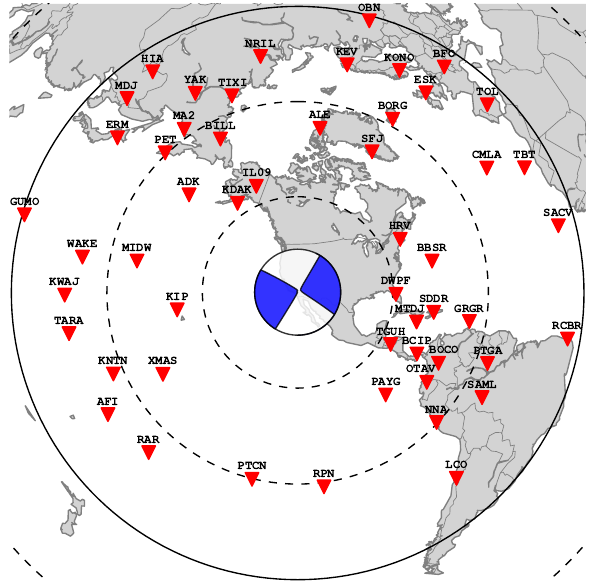
Figure 20. Stations used in the source inversion validation (SIV) exercise. Circles mark 30, 60 and 90 ◦ epicentral distance. The fi- nite source is a M 7.8 strike-slip earthquake in southern California represented by ≈ 10 5 point sources, the beach ball represents the centroid moment tensor, i.e. the orientation and predominant direc- tion of slip of the overall